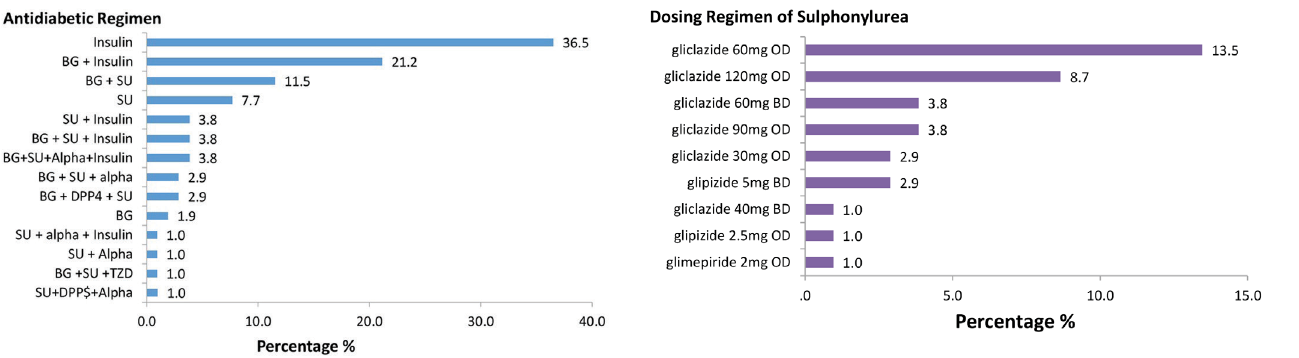
FIGURE 5 - Sulphonylurea dosing agents for T2DM patient with DR; BD, twice daily; OD, once daily; TDS, three times daily.